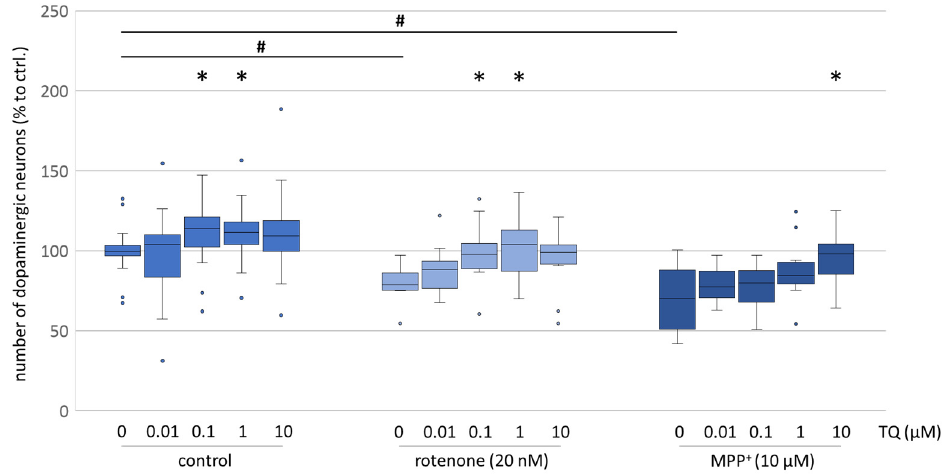
Figure 1. Effects of TQ on the number of THir (dopaminergic) neurons in rotenone- or MPP + -affected primary mesencephalic cultures after 48 h treatment. Specifically, 100% corresponds to the number of dopaminergic neurons in the untreated controls (0 µM TQ, 0 nM rotenone, 0 µM MPP + ). The data represent at least five independent experiments. Statistically significant differences between the TQ groups compared to the respective controls were determined using the Kruskal–Wallis (H) test followed by the χ 2 test (* p < 0.05). The Mann–Whitney (U) test was used to evaluate the effects of rotenone/MPP + vs. the control (# p < 0.05).